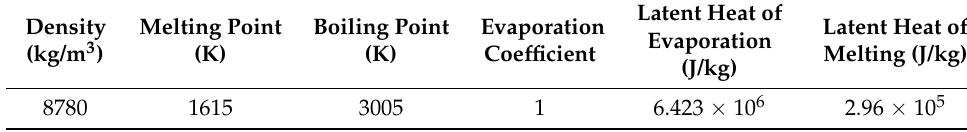
Table 3. Material properties of the DD6 single-crystal